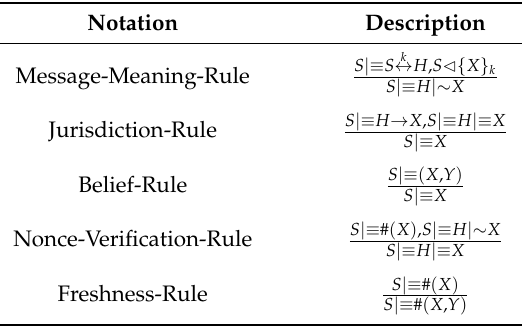
Table 3. Ban Logic inference